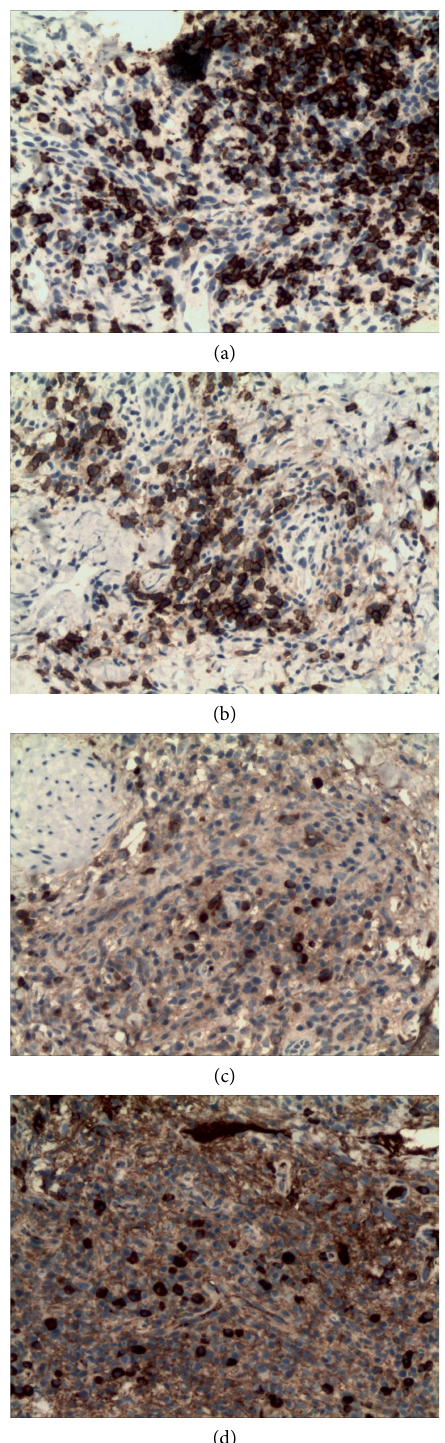
Figure 3: Immunohistochemical staining showed that lym phocplas- mocytes infiltration in the cutaneous dermal layer. (a: